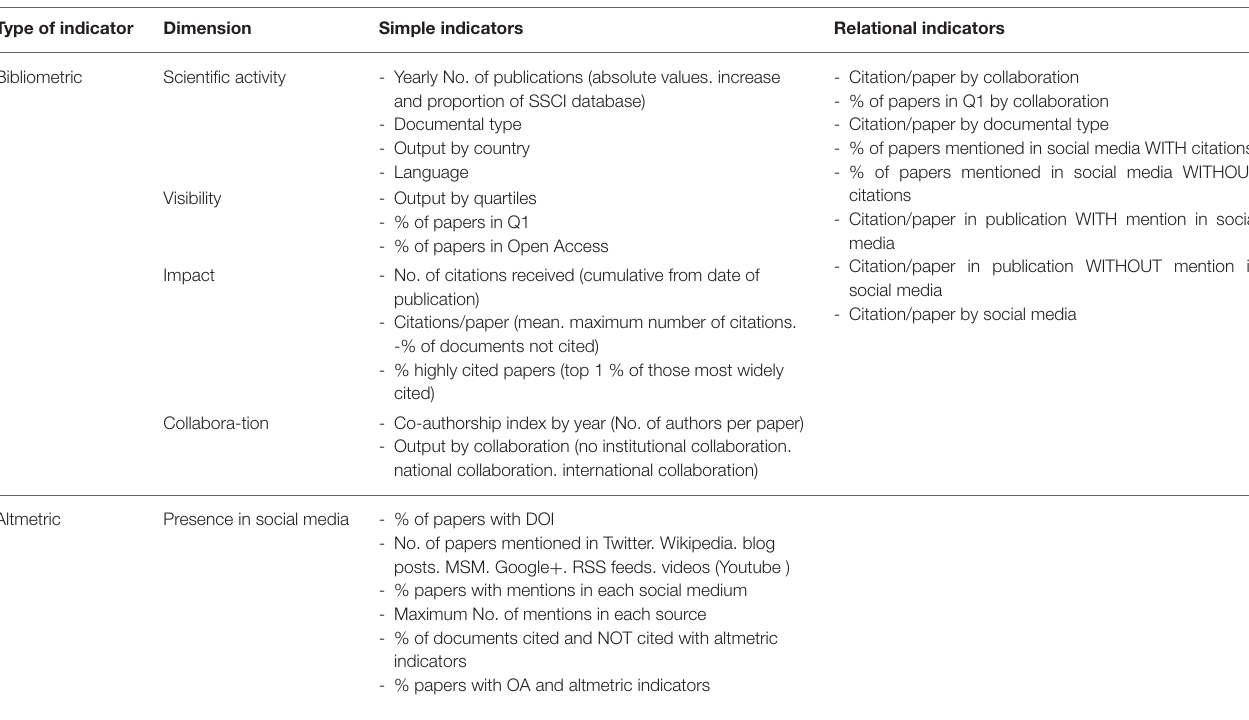
TABLE 1 | Dimensions and indicators studied in the